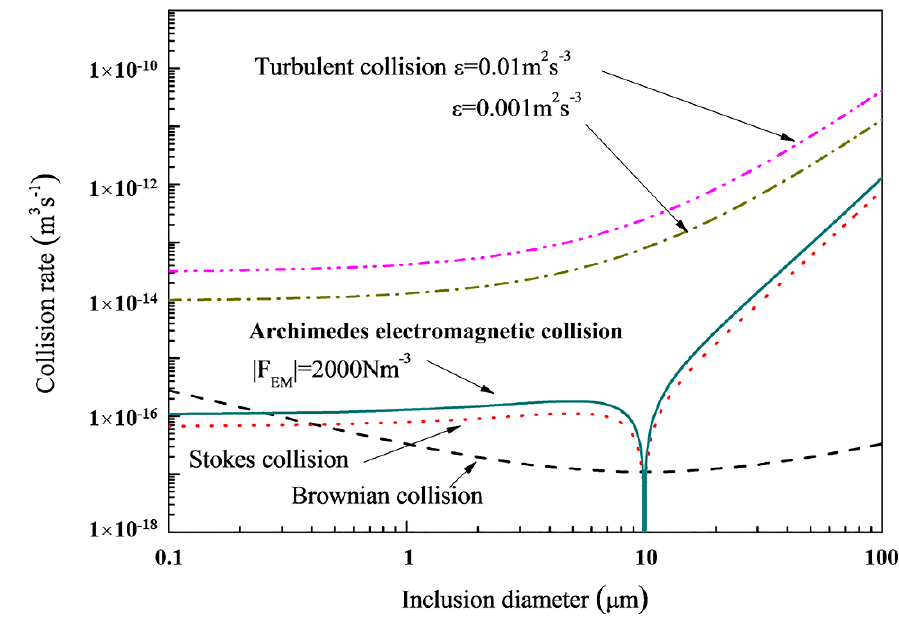
ff erent collision rates in the case of Figure 8. Different collision rates in the case of M-EMS. Figure 8. Di